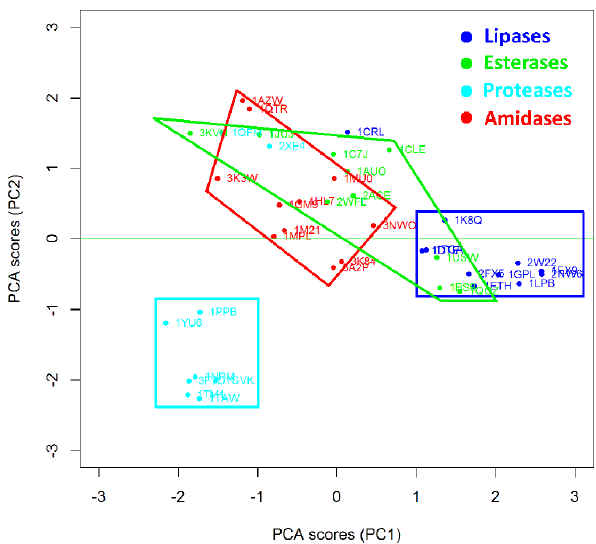
Figure 3. Unsupervised Pattern Cognition Analysis (UPCA) and clustering of Ser hydrolases on the basis of BioGPS descriptors (global score). The enzymes are labelled according to their PDB code. Lipases are indicated in blue, esterases in green, amidases in red and proteases in cyan.